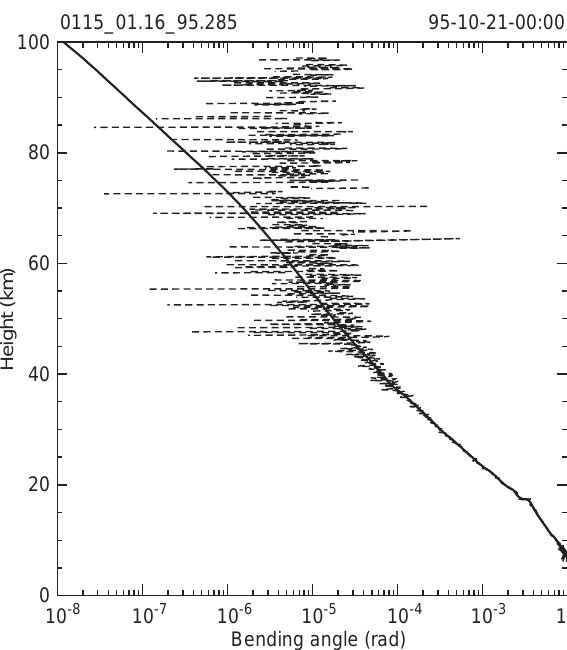
Fig. 4. A typical bending angle profile calculated from GPS/MET phase measurement data ( dotted line ) for the same occultation event as in Fig. 3. It is compared to a profile ( solid line ) obtained after a combination of the GPS/MET bending angle profile and the co- located MSISE-90 model bending angle profile using a statistical